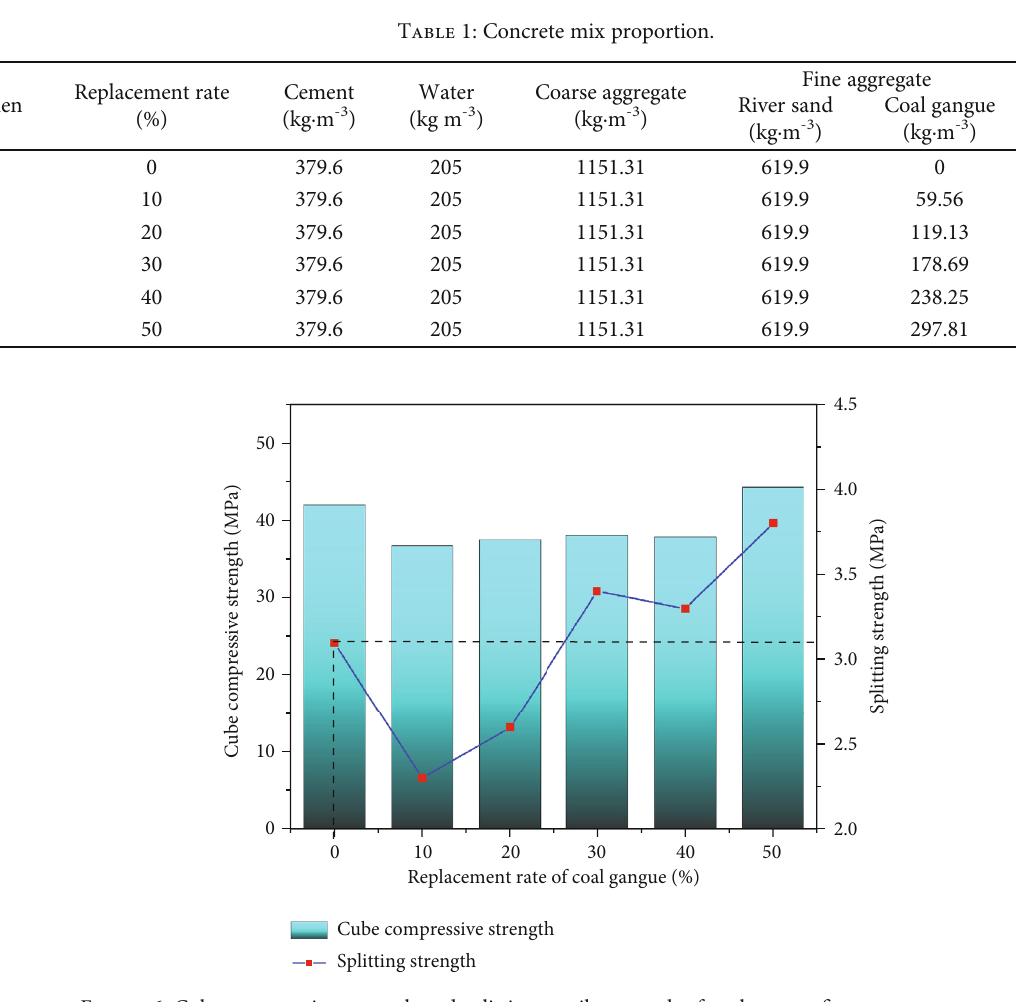
Figure 6: Cube compressive strength and splitting tensile strength of coal gangue fi ne aggregate